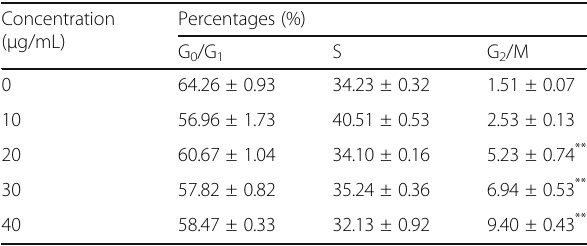
Table 1 Percentages of A549 cells in S-, G0/G1-,and G2/M- phase (±s, n = 3)